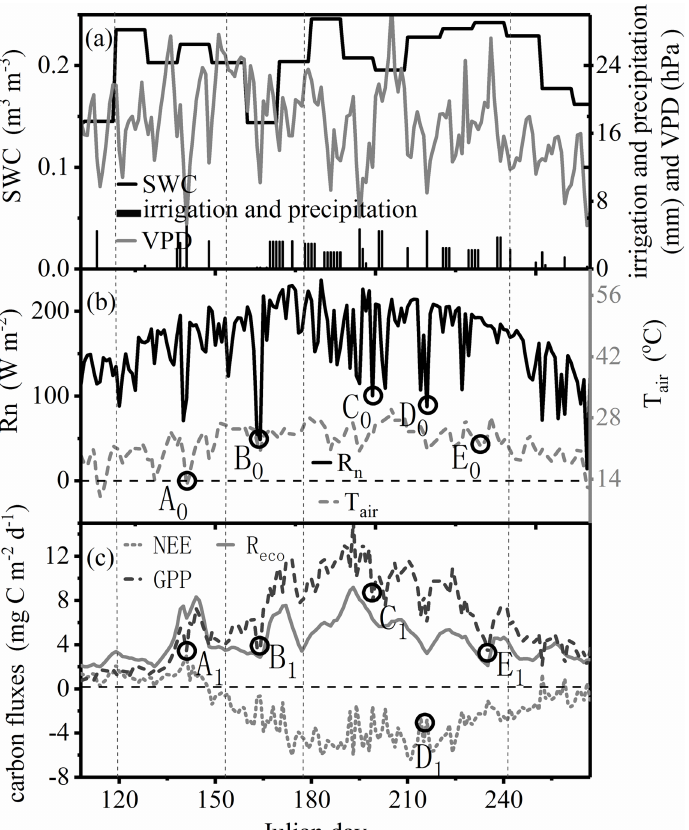
Fig 4. Total daily GPP (gross primary production) and mean daily T air (air temperature), R n (net solar radiation), rainfall, VPD (vapor pressure deficit) and SWC (soil water content). The vertical dotted lines are the boundaries of different growing stages. The horizontal dotted lines represent the zero